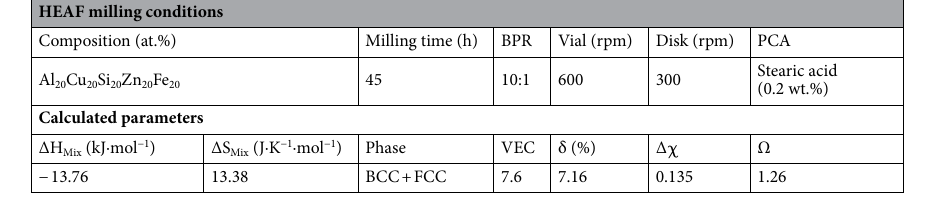
Table 1. Milling conditions of HEAF